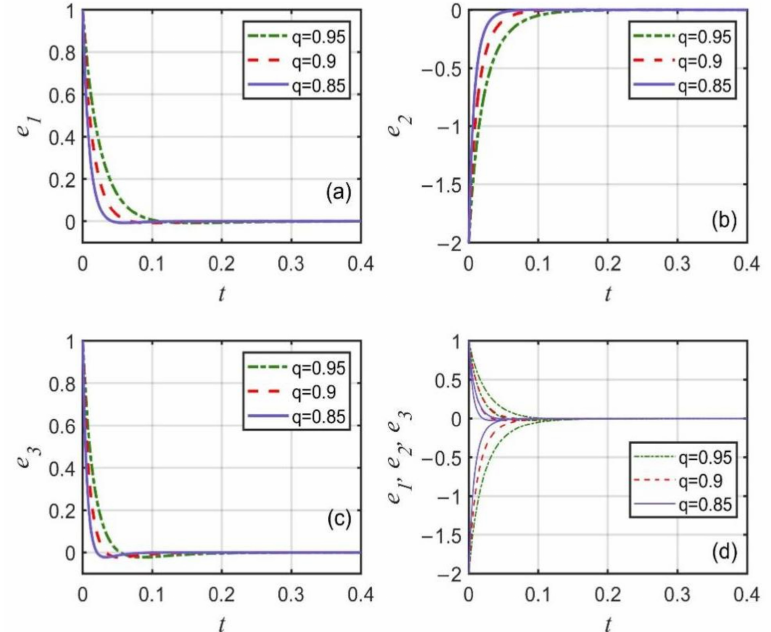
Figure 12. Synchronization error of ( a ) e 1 ; ( b ) e 2 ; ( c ) e 3 ; ( d ) e 1 , e 2 and e 3 with some different frac- tional orders.